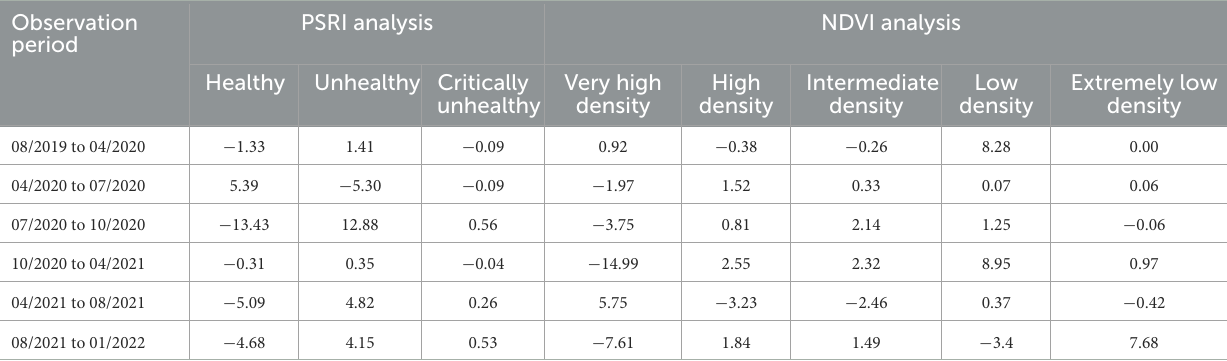
TABLE 2 Rate of land cover changes (ha month − 1 ) in the mangrove area of East Lampung, Sumatra, based on PSRI and NDVI analyses in August 2019–January 2022. Observation PSRI analysis NDVI analysis period Healthy Unhealthy Critically Very high High Intermediate Low Extremely low unhealthy density density density density density 08/2019 to